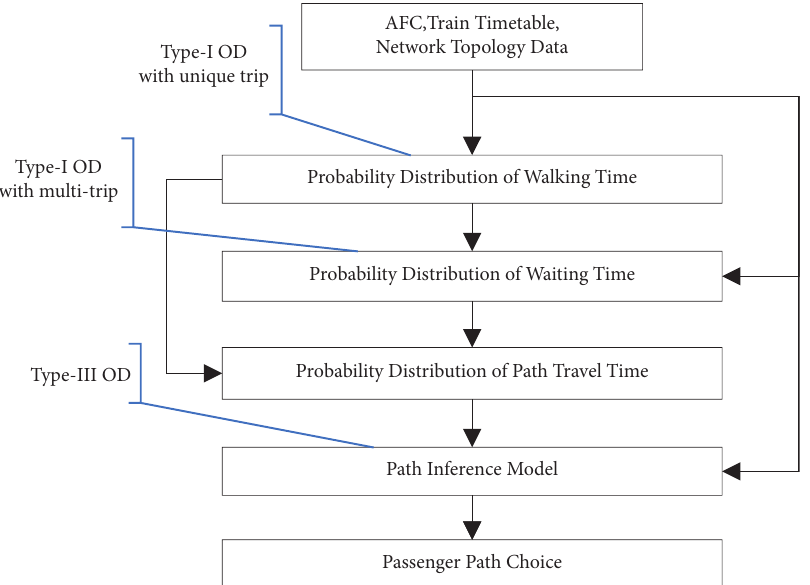
Figure 3: Calculation flow of passenger path choice.